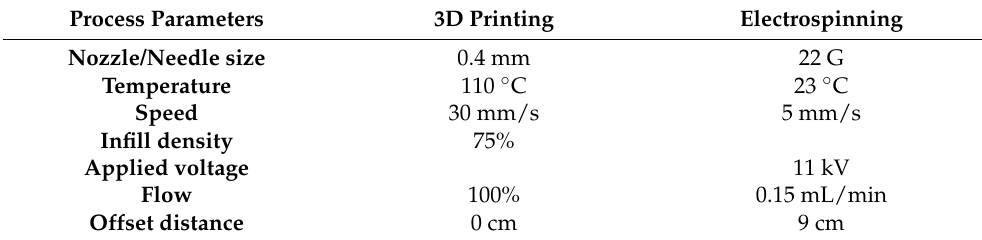
Figure 1. Hybrid PCL scaffolds. ( A ) Domotek domoBIO 2A bioprinter, equipped with an electro- spinning module and a filament extruder, used to manufacture the scaffolds. ( B ) Macroscopic image of a hybrid PCL scaffold. ( C ) SEM image of the scaffold cross section; scale bar: 500 µm. ( D ) SEM image of the scaffold surface; scale bar from left to right hand: 1.00 mm, 100 µm, and 30.0 µm. Table 1. Summary of processing conditions of hybrid PCL scaffolds.